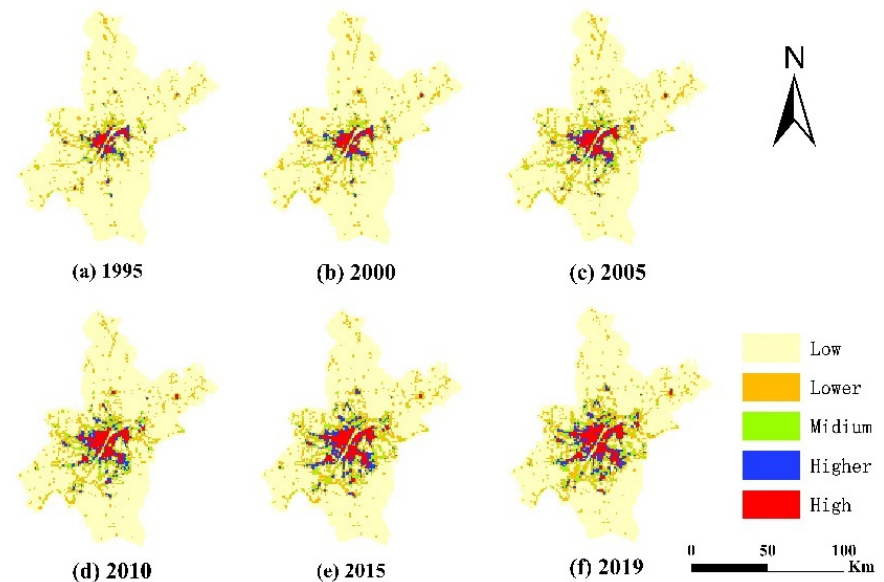
Figure 5. Spatial distribution of carbon emissions within a unit area in Wuhan, 1995–2019.